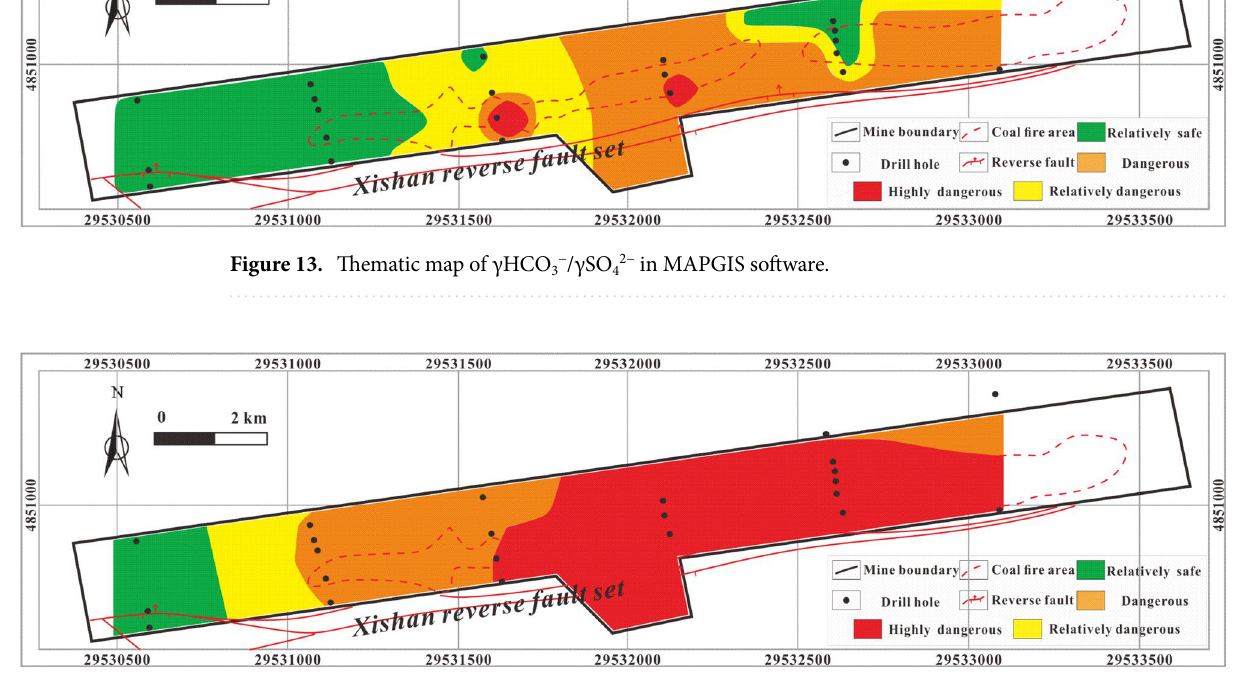
Figure 14. Thematic map of total sulfur concentration in MAPGIS